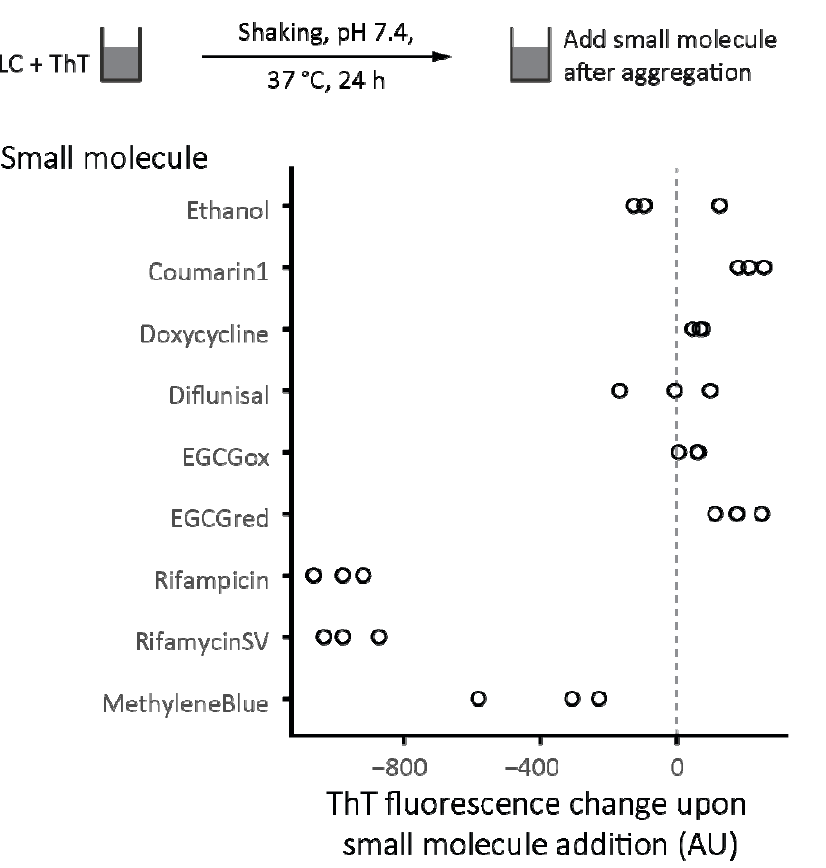
Figure 7. The effect of addition of small molecules to pre-formed, ThT-bound fibrils. Fibril formation was monitored by ThT fluorescence as described in Figure 6. The decrease in ThT fluorescence shown for rifampicin, rifamycin SV, and methylene blue is consistent with fluorescence quenching or displacement of ThT from fibrils.